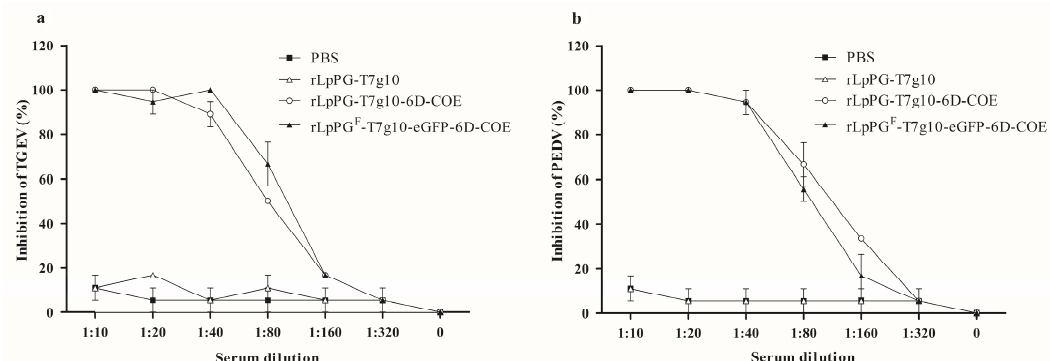
Figure 6. Neutralizing capacities of serum antibodies in immunized mice. Anti-PEDV (porcine epidemic diarrhea virus) ( a ), and anti-TGEV (transmissible gastroenteritis virus) ( b ) neutralizing antibodies in immunized mice were detected by plaque reduction assay with different serum dilutions from blood samples taken at 35 days post-immunization.